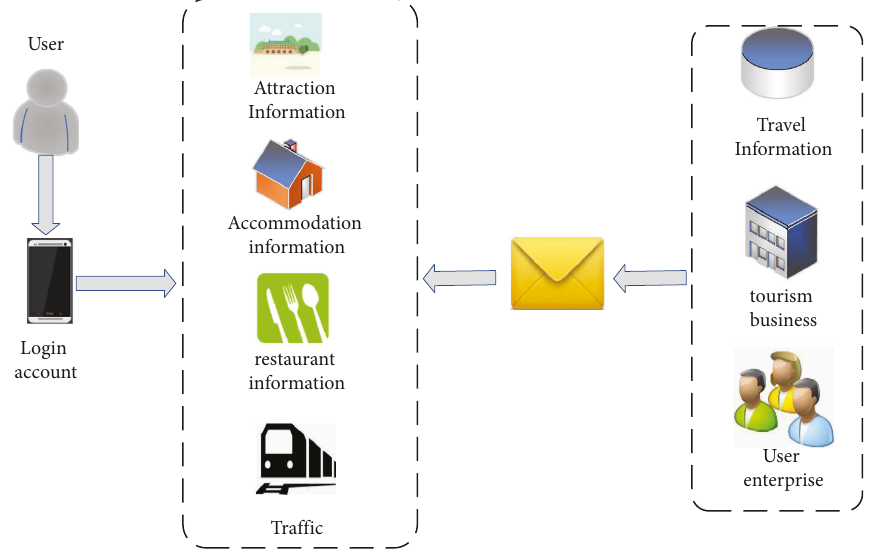
Figure 2: System business flow